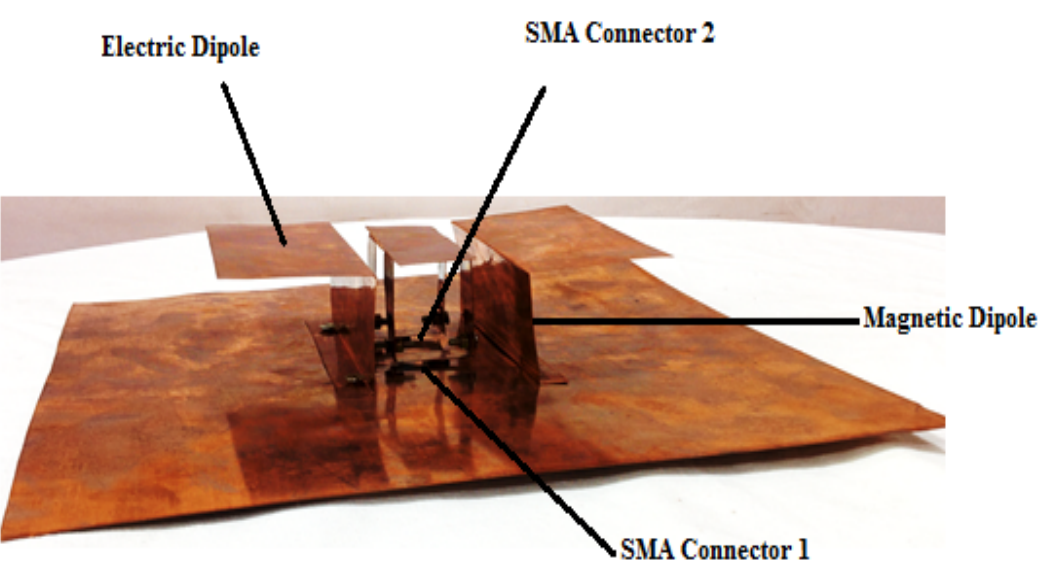
Figure 1a. Prototype of proposed antenna with side view of feed